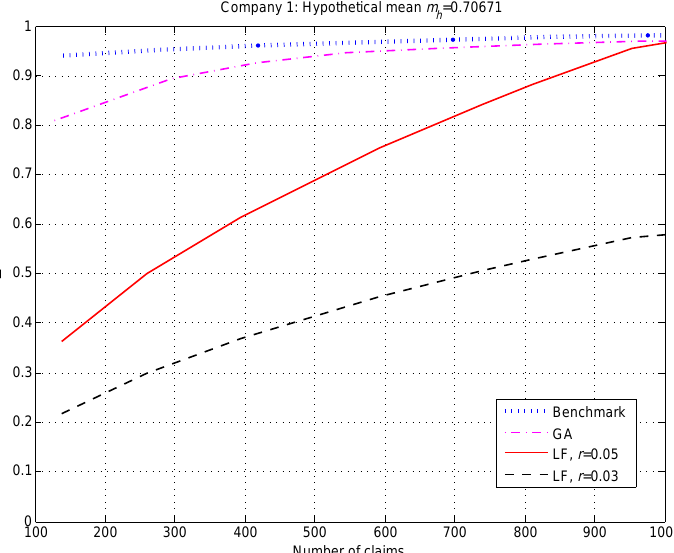
Figure 2. We contrast the Benchmark, GA, and LF credibility factors for “company” (risk class) 1, whose hypothetical mean is m 1 ≈ 0.707.